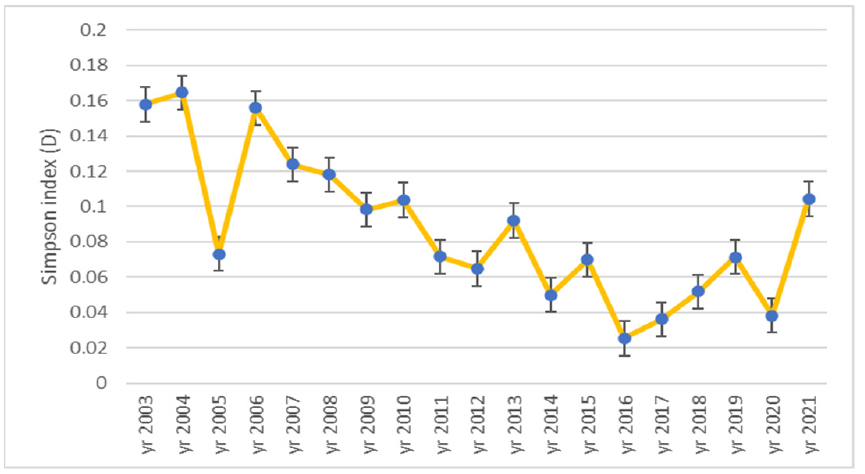
Figure 6. Dynamics of Simpson index (D) during 2003–2021 time interval in ex-arable grassland from Gr ă dinari (standard error displayed).